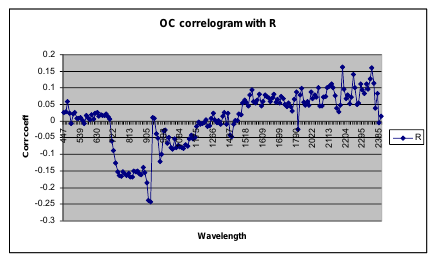
Fig 8 Correlogram of organic carbon with four spectral